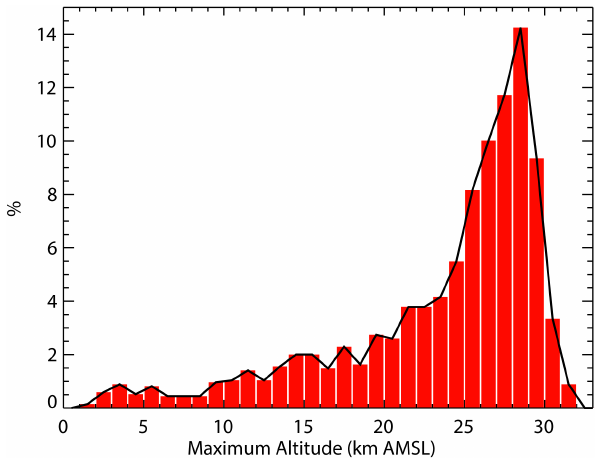
Figure 3. Frequency of occurrence (normalized by the total number of soundings) of the maximum height obtained by MC3E sound- ings, for all